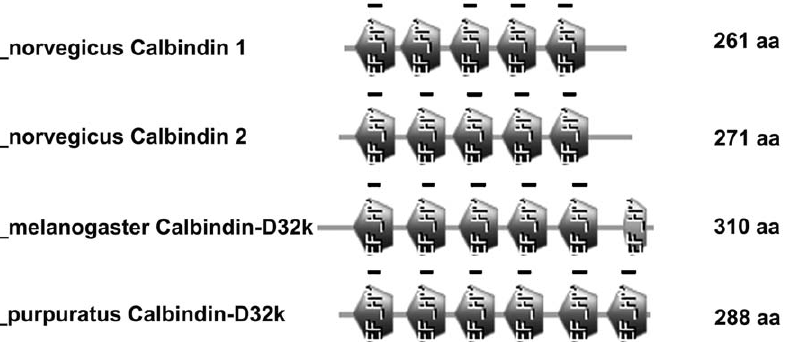
Figure 5. Schematic domain structure of members of the calbindin subfamily in rat ( R.norvegicus ), fly ( D.melanogaster ), and sea urchin ( S.purpuratus ). Domains 1, 3, 4, and 5 are present in all the proteins. The second domain doesn’t bind calcium in the calbindin 1 protein, while it does in calbindin 2, and in Drosophila and S. purpuratus’ calbindin-D32k. Domain 6 is present in Drosophila calbindin-D32k and S. purpuratus calbindin-D32k, but it is only able to bind calcium in the latter. Pairwise similarities of domains between proteins were calculated by aligning the domains as predicted by ScanProsite.